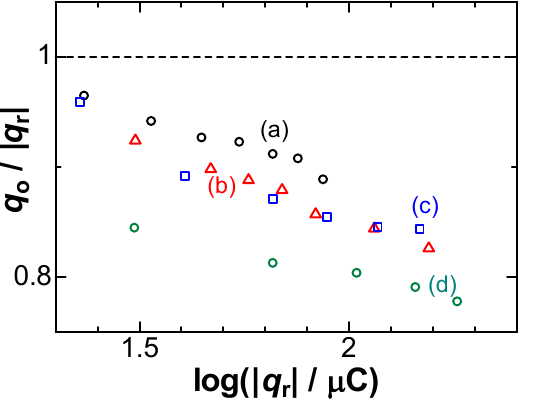
Figure 3. Plots of q o /| q r | vs. log| q r | at rotation rates of ( a ) 0; ( b ) 0.25; ( c ) 0.67; ( d ) 1.50 rps in 0.05 mM AgNO 3 + 50 mM NaNO 3 for v = 10 mV s −1 .